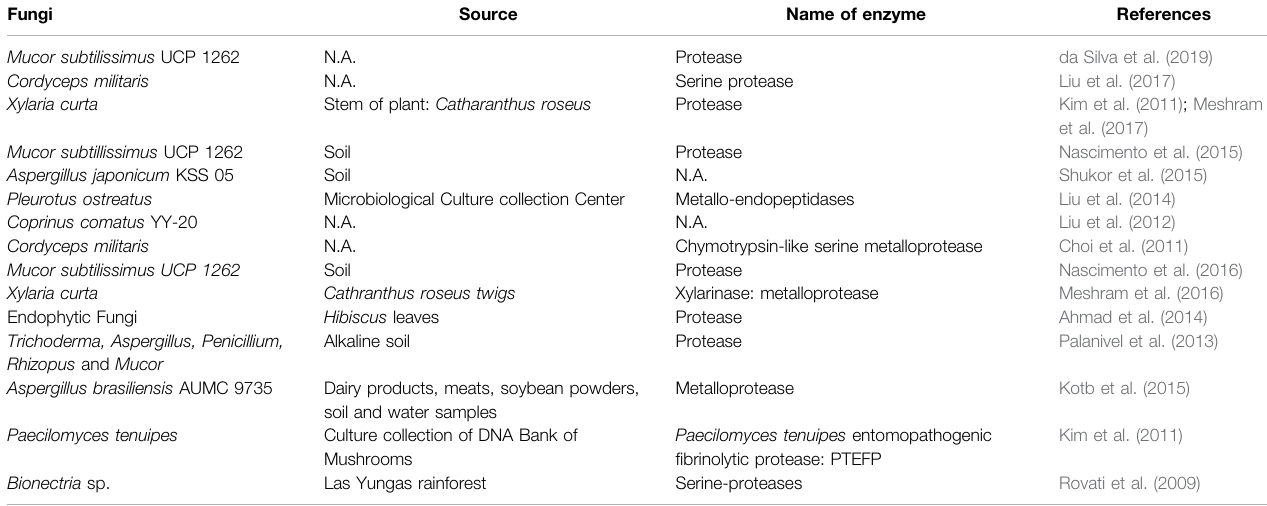
TABLE 3 | Fibrinolytic enzymes obtained from fungi from different sources.